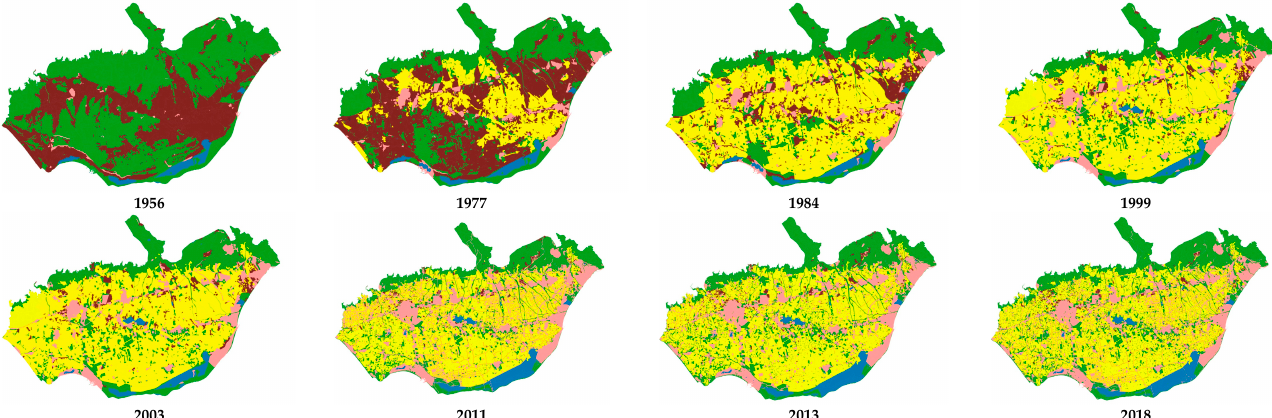
Figure 2. Sequential maps of aggregate classes from 1956 to 2018. Intensive agriculture (yellow), scrubland (green), settlements (pink), traditional agriculture (brown), water (blue).